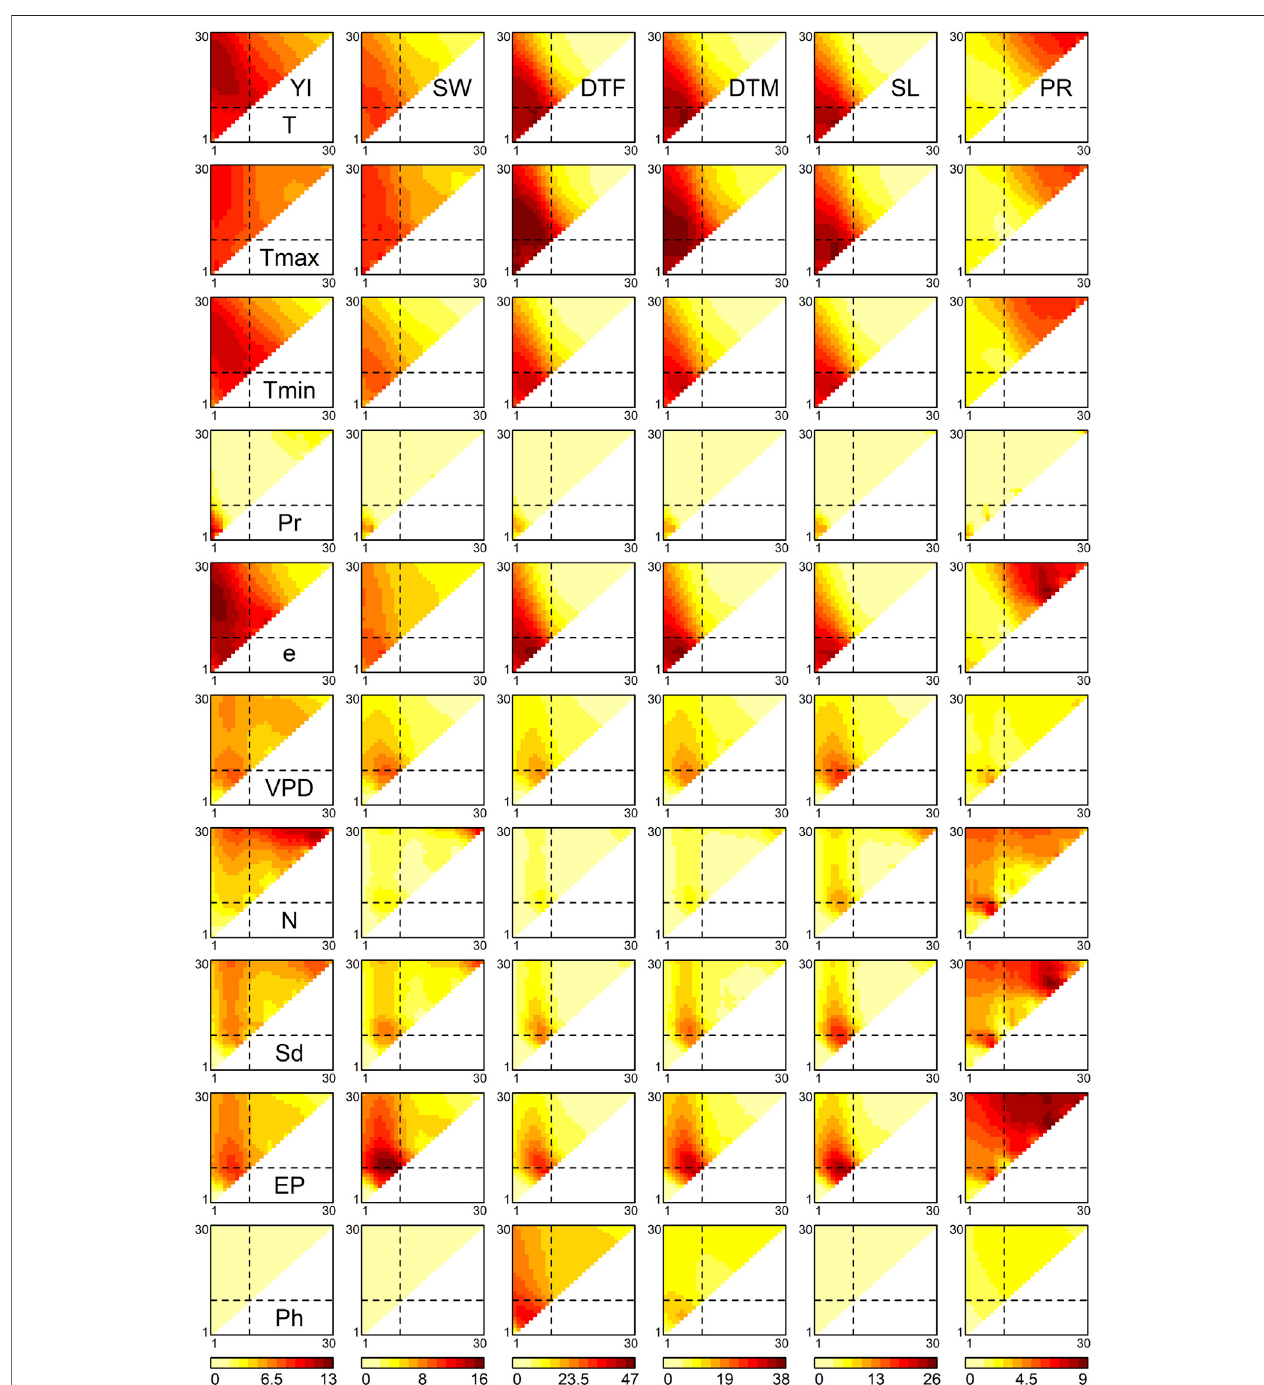
FIGURE2| Associationsofenvironmental covariates withgenetic correlations betweenenvironments. Theheatmaps represent the − log10 p valuesofcorrelation coef fi cients of off-diagonal elements between the similarity matrix of each environmental covariate and the genetic correlation matrix. The diagonal elements of the triangles correspond with the 1st to 30th growth stages, from the lower left to the upper right. The off-diagonal elements correspond to the growth periods that span multiple stages, where the x and y axes denote the start and end of the periods, respectively. The broken lines indicate fl owering time. Abbreviations: YI, yield; SW, seed weight; DTF, days to fl owering; DTM, days to maturity; SL, stem length; PR, protein content; T, mean temperature; Tmax, maximum temperature; Tmin, minimum temperature; Pr, precipitation; e, vapour pressure; VPD, vapour pressure de fi cit; N, hours of sunshine; Sd, solar radiation; EP, potential evapotranspiration; Ph,